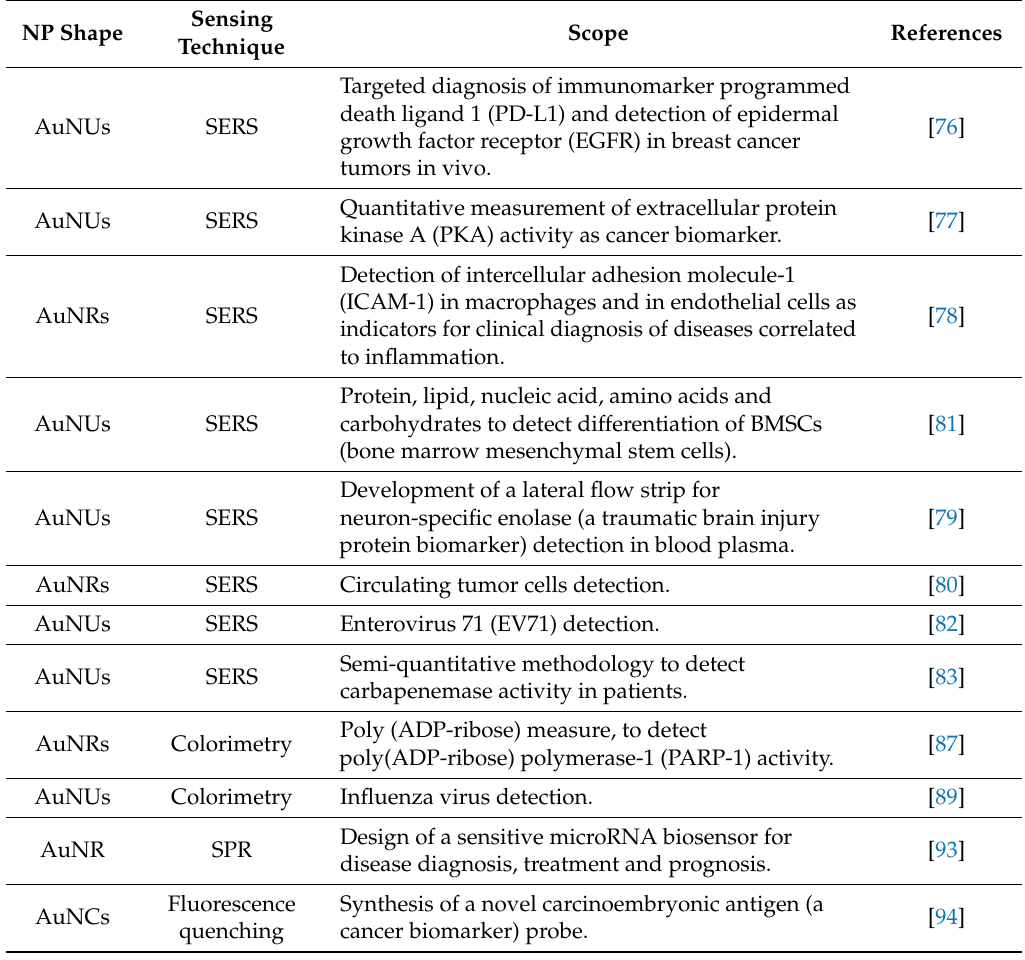
Table 1. Overview of anisotropic gold nanosystems used in